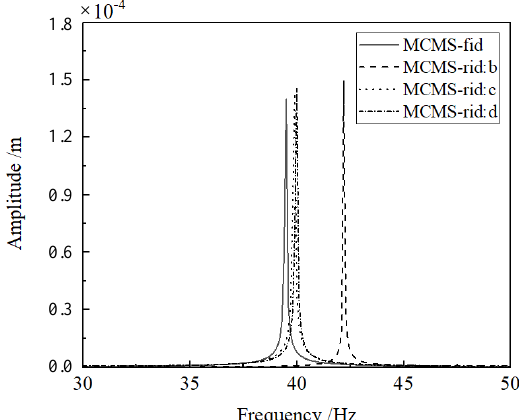
Figure 7. Frequency response functions of the beam by the MCMS-fid method and MCMS-rid method with different interpolation schemes for the first mode.